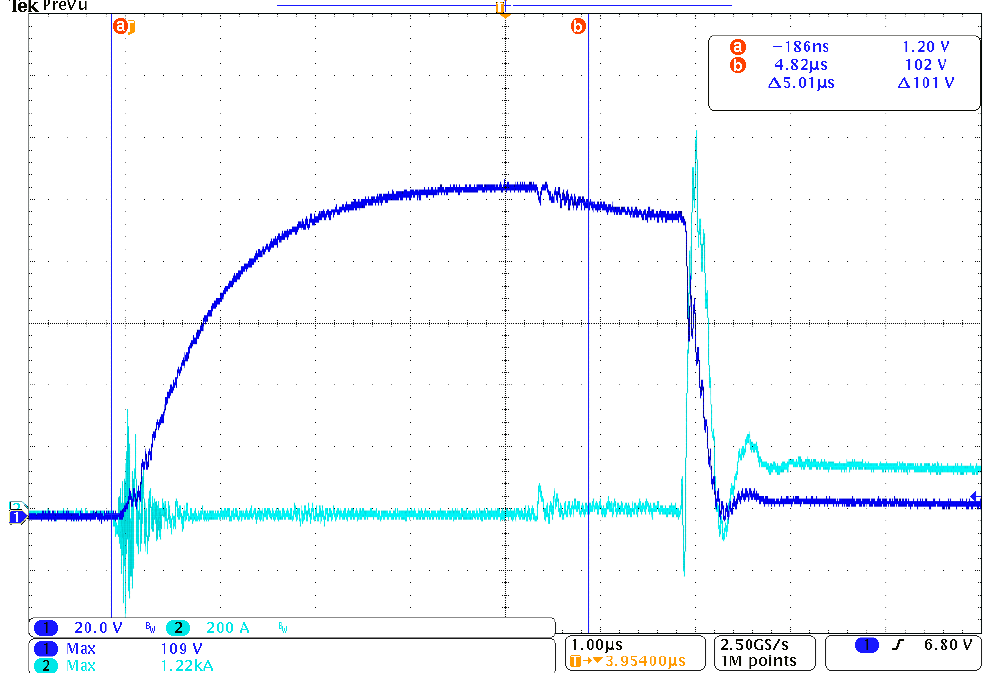
Figure 8. Waveform of voltage and current as a result of applying a positive lightning discharge pulse voltage to the LFA.